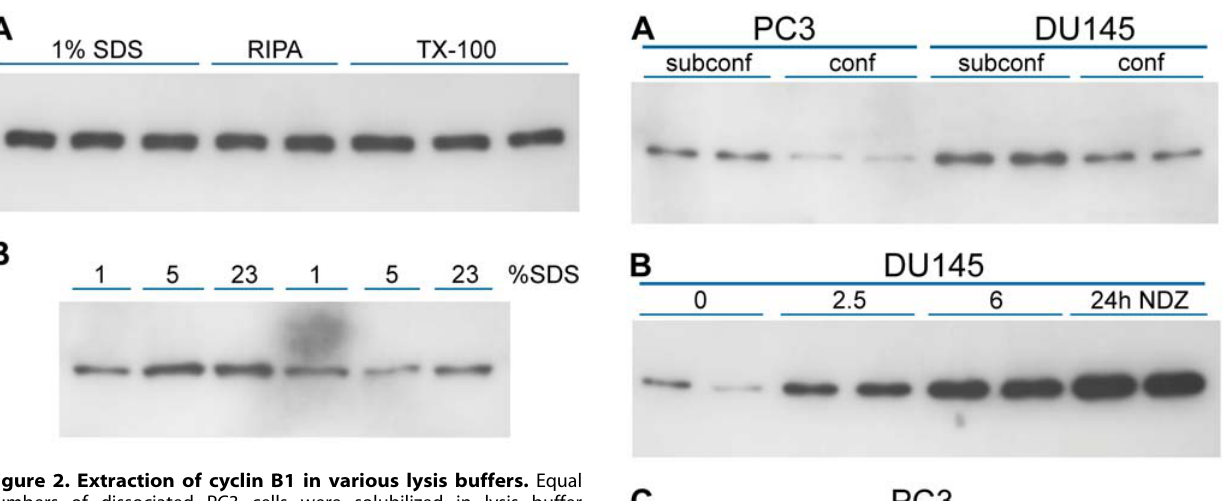
SDS. The lanes were loaded with equal numbers of cells.